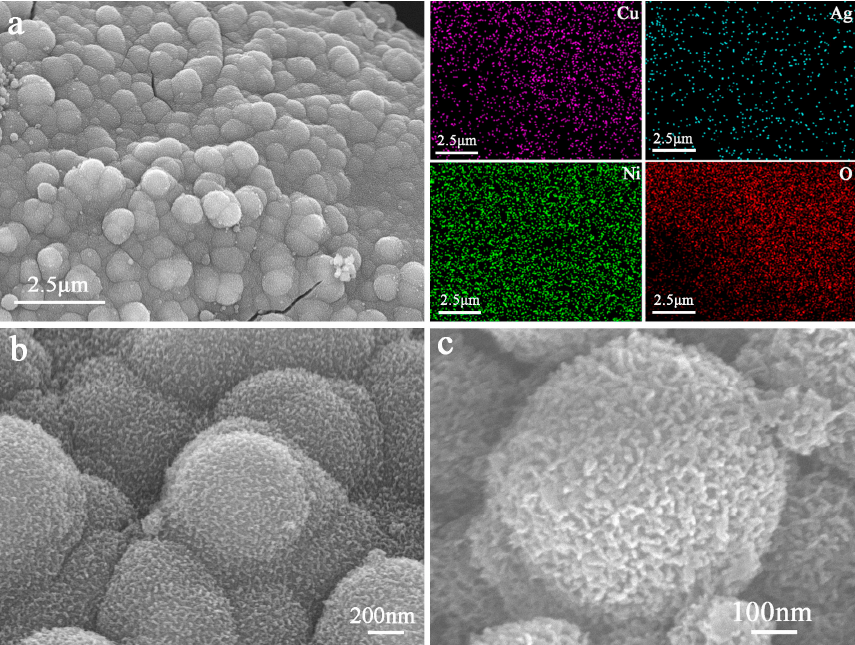
Figure 3. FE-SEM images of the Ag@Ni(OH) 2 composite with 300 s the deposition time of Ni(OH) 2 : ( a ) Low magnification image and the EDS element mapping; ( b , c ) high magnification